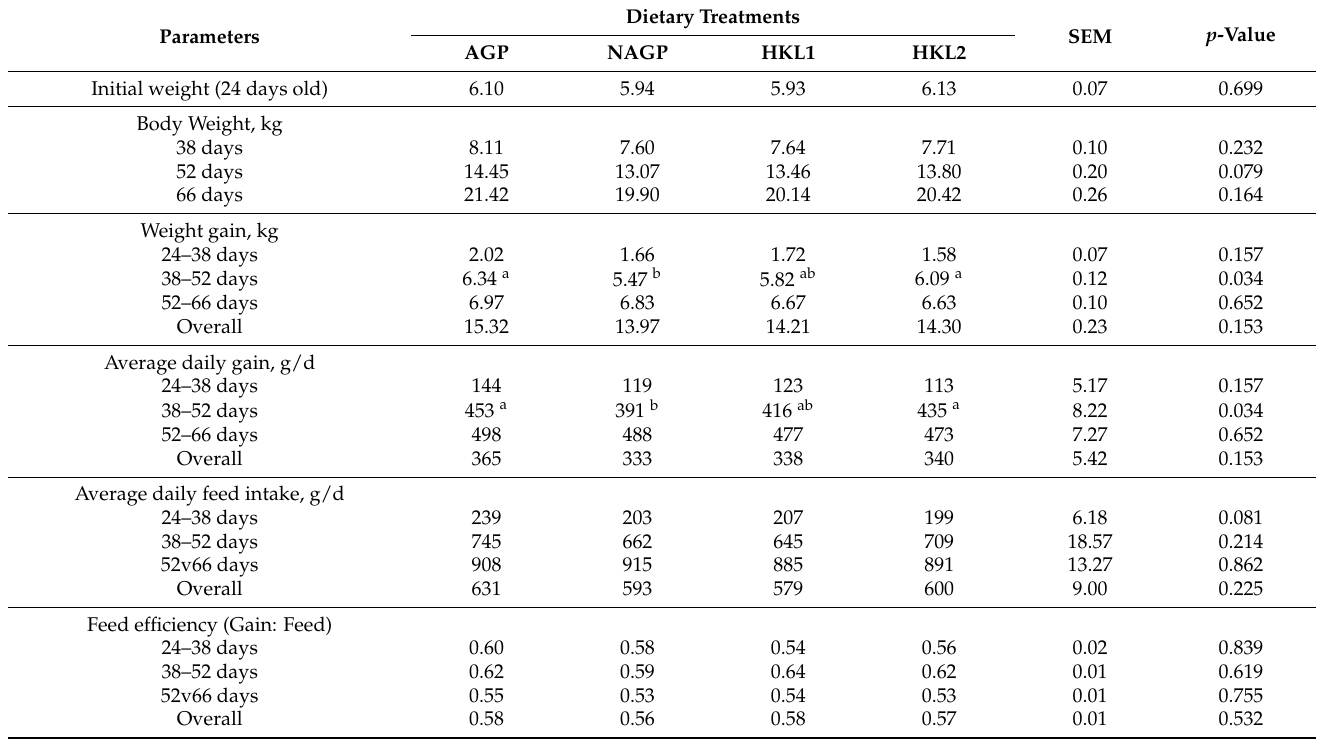
Table 4. Effects of the dietary treatments on the growth performances of the pigs from the weaner phase to the starter phase (24 to 66 days old).